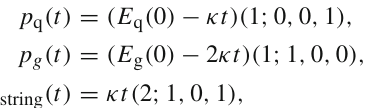
displays the different string regions in terms of the light-cone − = p = p ¯ four-vectors defining each region, i.e. p + q , p q ¯ q q = p − = p / 2 in the qg ¯ q case, whose parameter and p + g g g plane is displayed in Fig. 7. The low regions represent the states in which none of the partons have lost their energy, corresponding to the two string regions in view 1 of Fig. 6, the qg and the g ¯ q string pieces. The intermediate region cor- responds to the new string piece created from the q and ¯ q momenta once the gluon has lost all its energy. Finally, the upperregionsarerelatedtothetwostringpiecesformedwhen g re-appears. Although the complete parameter plane picture (for half a period) is the one shown in Fig. 7, the dashed upper regions are normally neglected, since the system is assumed to fragment before then. This reasonable assumption avoids a large number of complications for handling fragmentation in theseregions.Thethreeremainingregionsarethenformedby the combination of one + component and one − one, where ± no longer relates to motion along the ± z axis, but more generically denotes the reference vector directed towards ( + ) or away from ( − ) the q end of the